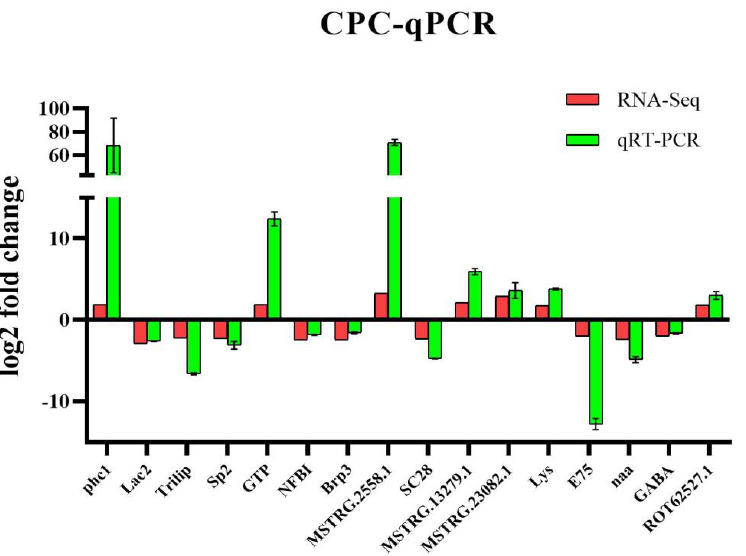
Figure 8. Validation of the associated DEGs by qPCR. Gene expression assays were performed in triplicate for each sample. Expression values were normalized to those of EF1α using the Litvak (2 -